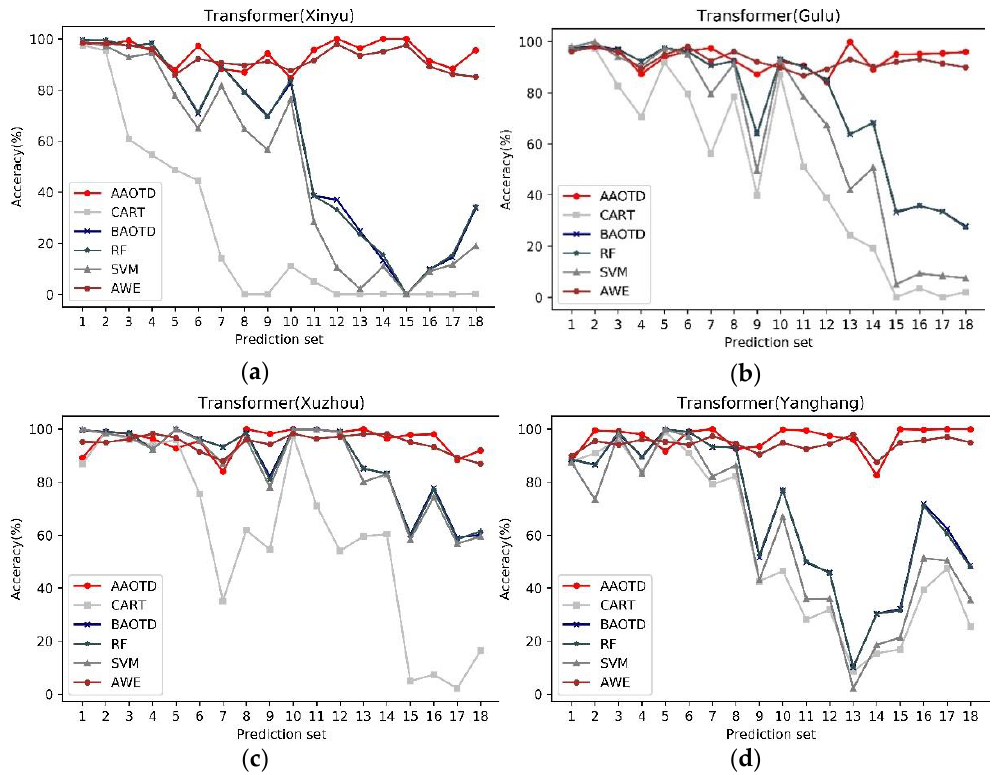
Figure 3. Chart of oil temperature prediction accuracy rate from various algorithms. The 4 subgraphs ( a – d ) show the results of 6 algorithms for oil temperature prediction of transformers in 4 different regions (Xinyu, Gulu, Xuzhou, and Yanghang). The x-coordinate represents the serial number of the prediction set, and the y-coordinate represents the accuracy of the predicted oil temperature.